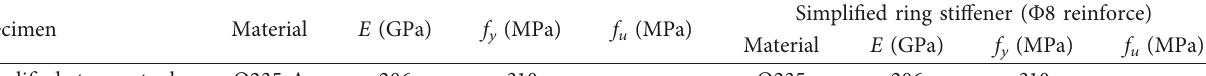
Table 2: Material properties of the test specimen.